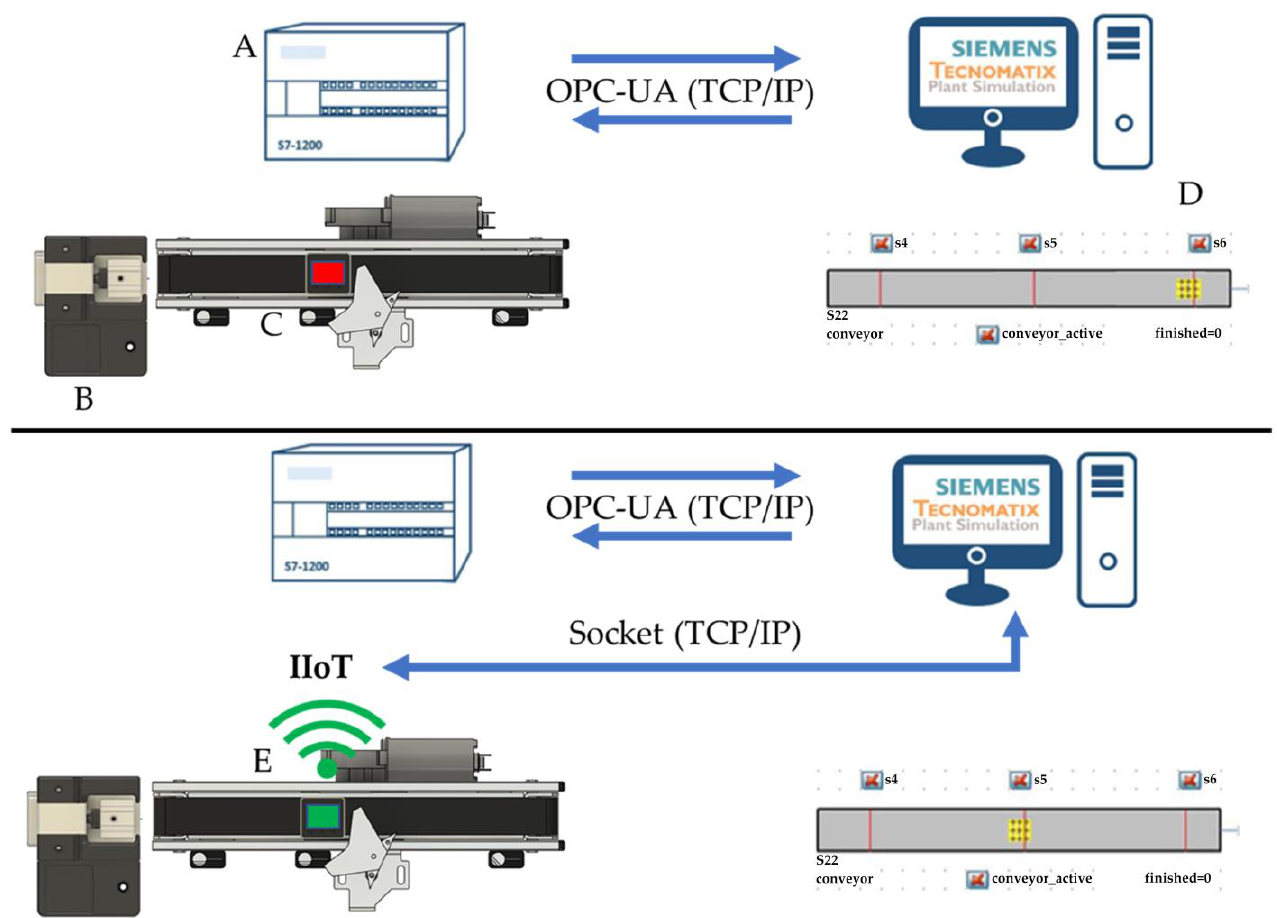
Figure 5. System architecture ( A — PLC, B — feeder, C — conveyor, D — digital twin, E — smart work- piece).